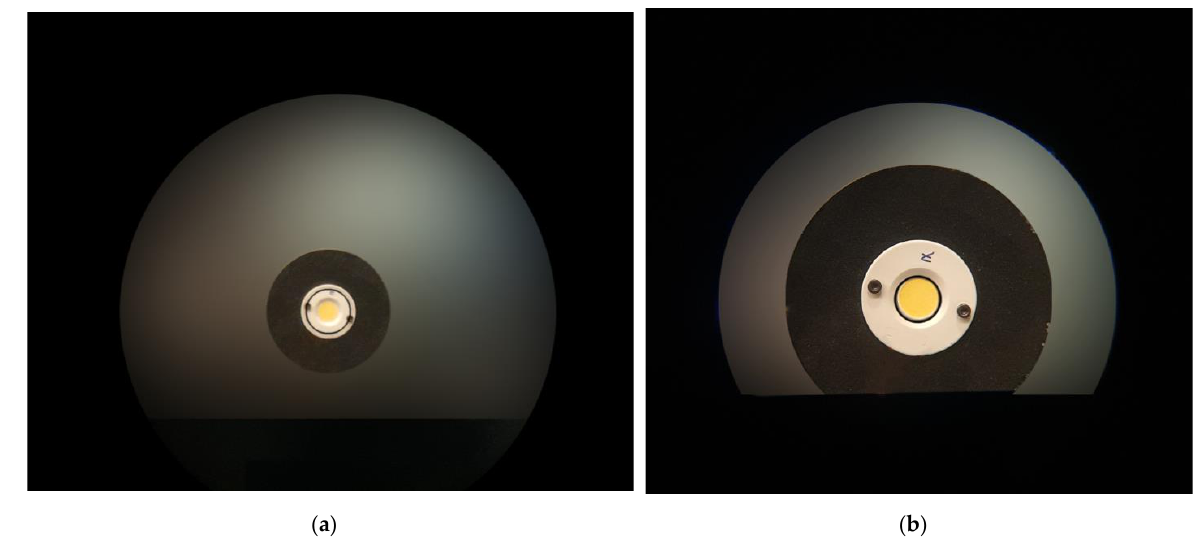
Figure 2. ( a ) The view from the meter ’ s lens, showing the measuring field exceeding the size of the measured light source. The incorrect direct measurement of luminance is shown — the area of the illuminating LED covers approximately 25% of the measuring field. ( b ) The correct direct measurement of luminance — the area of the luminous LED covers 100% of the measurement field. Matrix luminance meters (ILMDs) offer the most efficient measurement possibilities.